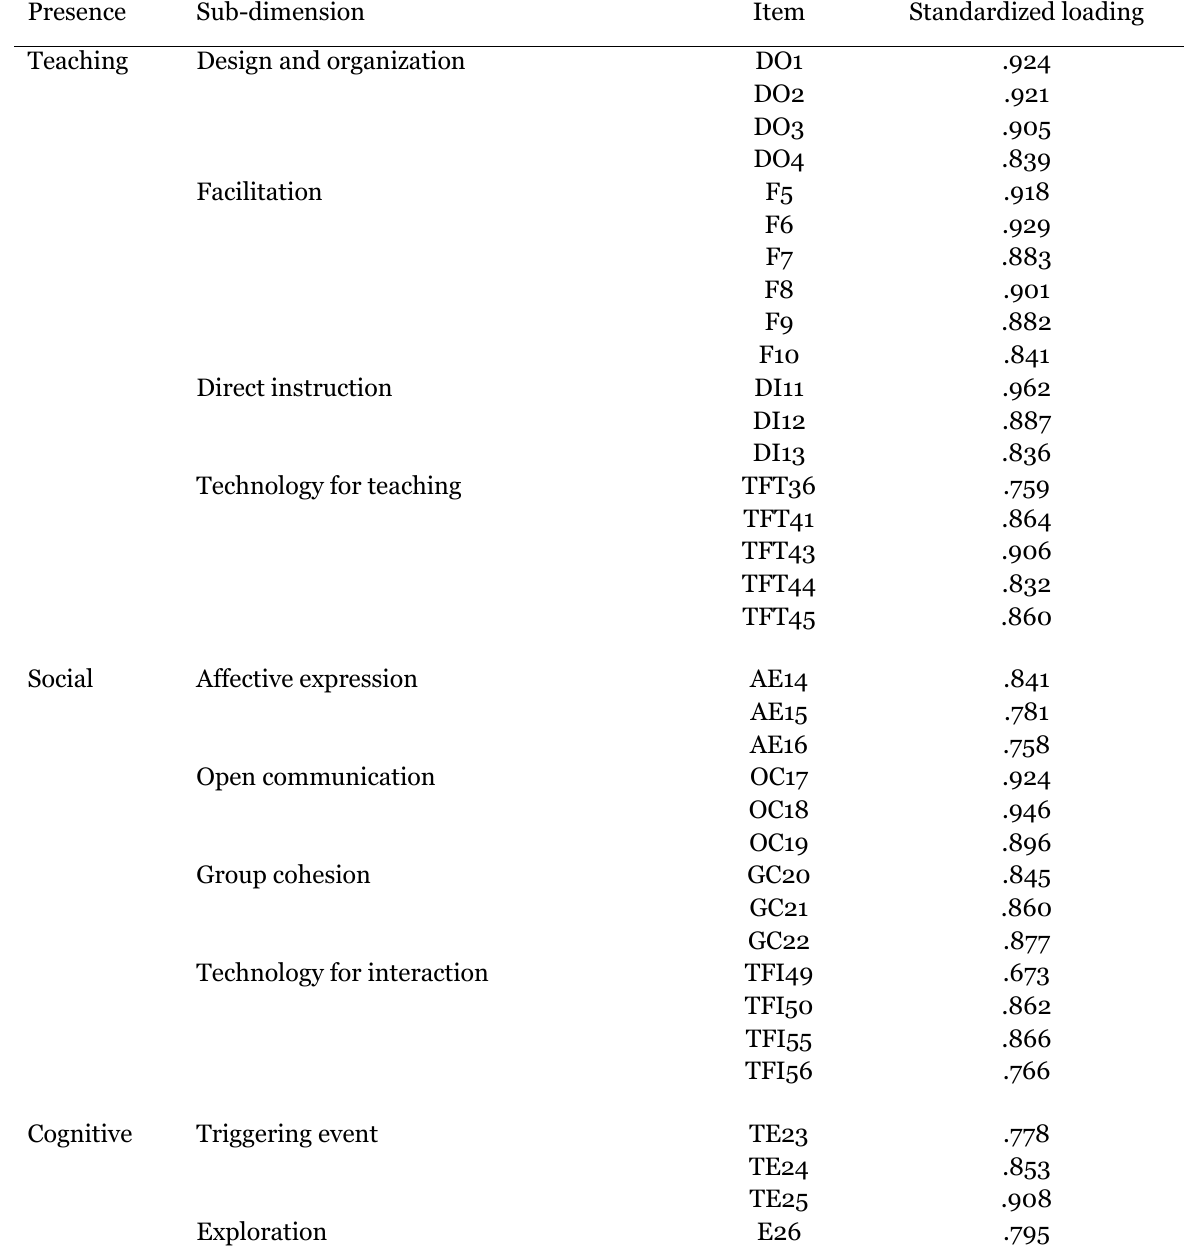
Standardized Factor Loadings of All Items Included in the Extended CoI Survey Presence Sub-dimension Item